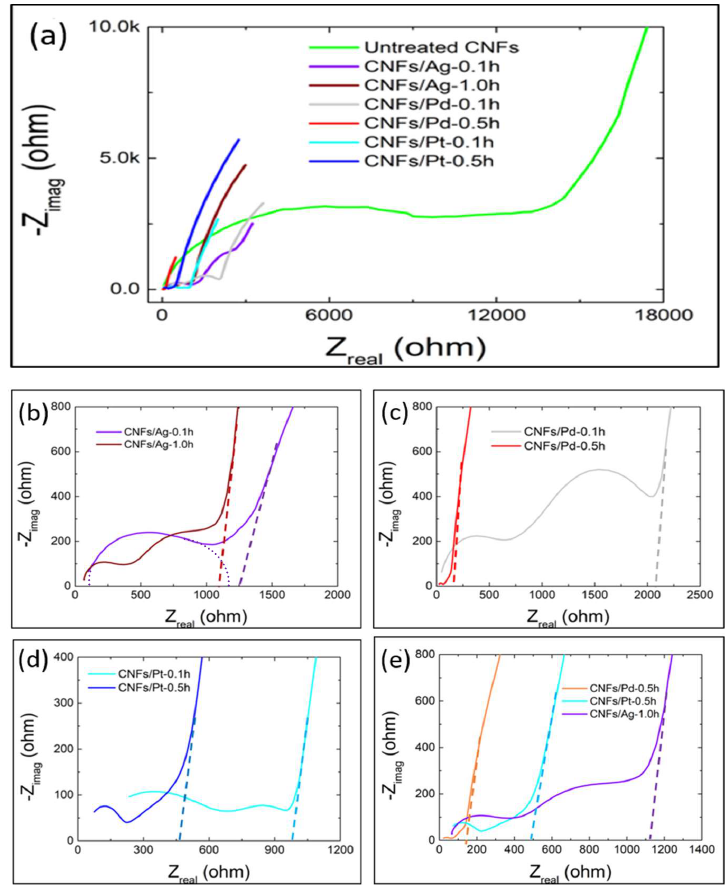
Figure 7. Nyquist plots of: ( a ) untreated and functionalised CNFs; ( b ) CNFs/Ag series; ( c ) CNFs/Pd series and ( d ) CNFs/Pt series and ( e ) CNFs/Ag-1.0h, CNFs/Pd-0.5h and CNFs/Pt-0.5h.